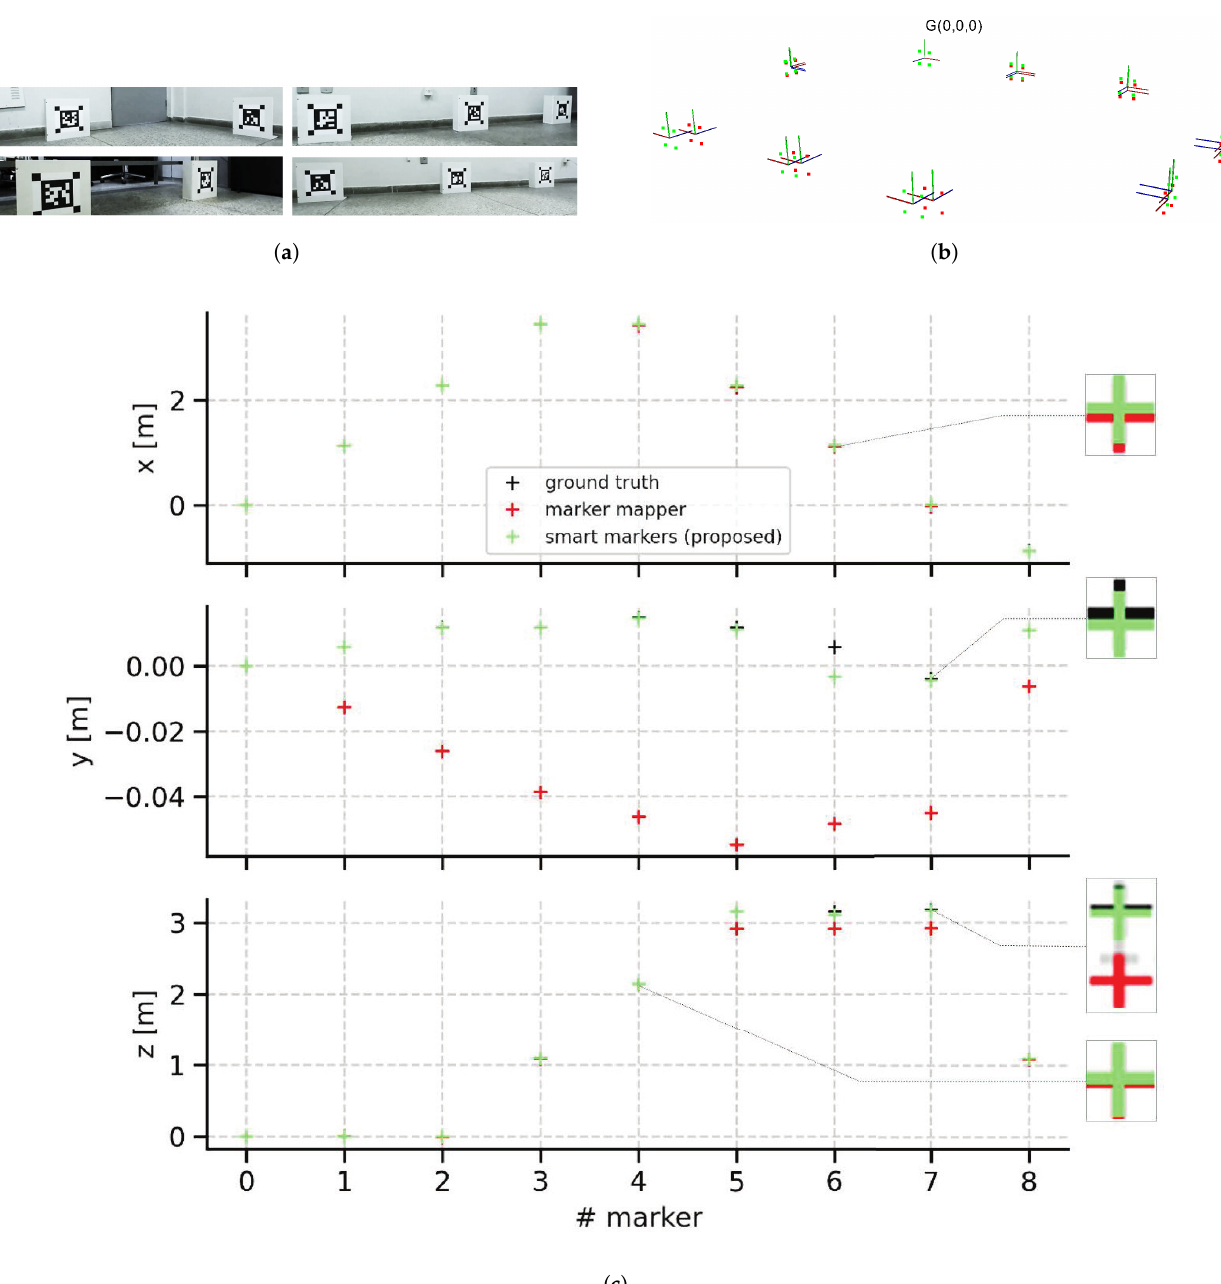
Figure 15. Evaluation of the mapping stage with smart markers with dataset M-Seq1/hall . Snapshots of smart markers distributed in the environments ( a ). Marker maps comparison ( b ). Three-dimensional reconstruction ( c ) in which red plus markers represent the Marker Mapper position estimates, green markers represent smart marker (our method) position estimates, and black are ground truth position